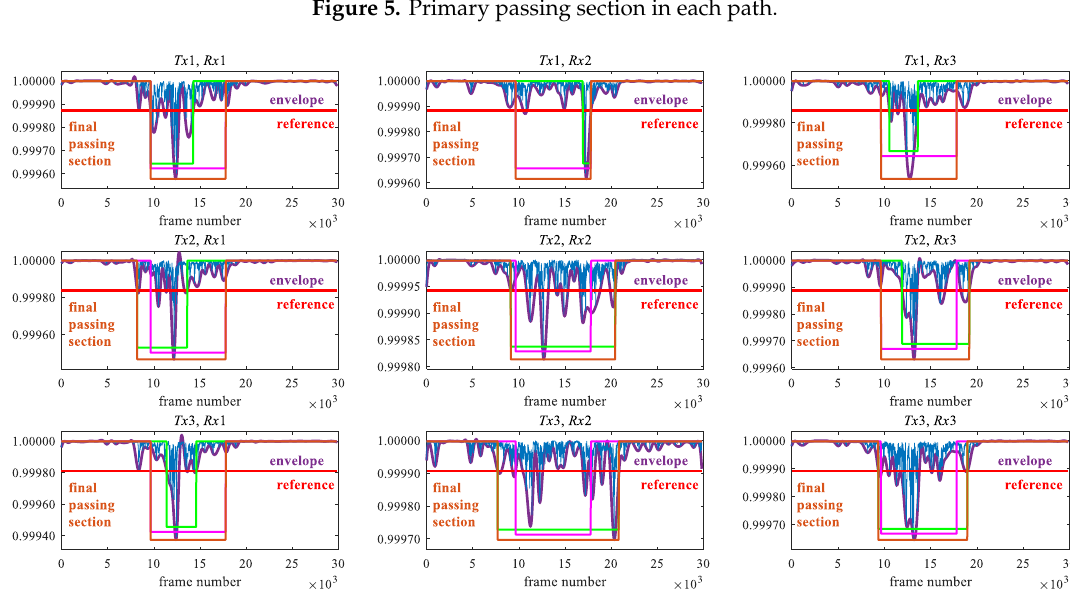
Figure 6. Final passing section in each path.